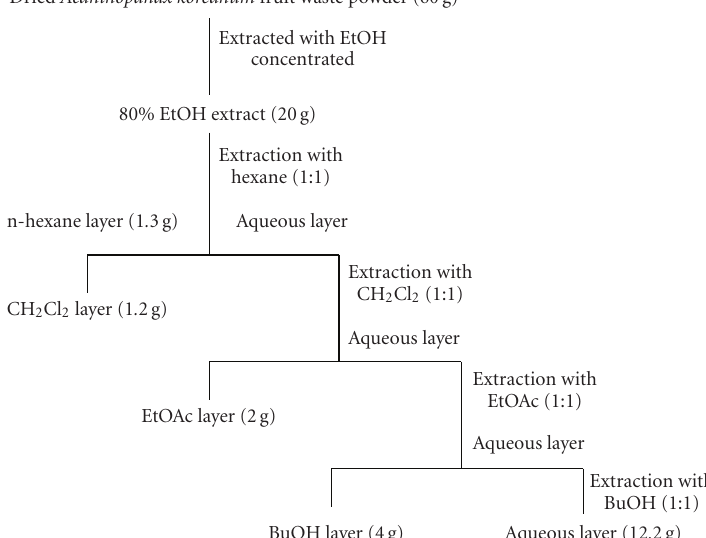
Figure 1: Fraction scheme of AFW ethanolic